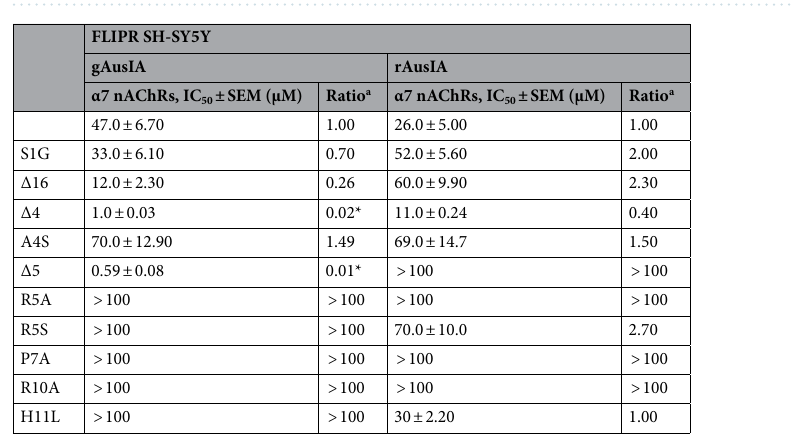
Figure 4. Functional characterisation of gAusIA and rAusAI at α7-containing nAChRs. Concentration response curves for gAusIA and rAusIA and their analogues at α7-containing nAChRs on SH-SY5Y cell are shown: ( a ) Termini changes, ( b ) loop 1 changes ( c ) loop 2 changes. Data represent mean ± SEM of triplicate data from three independent experiments.